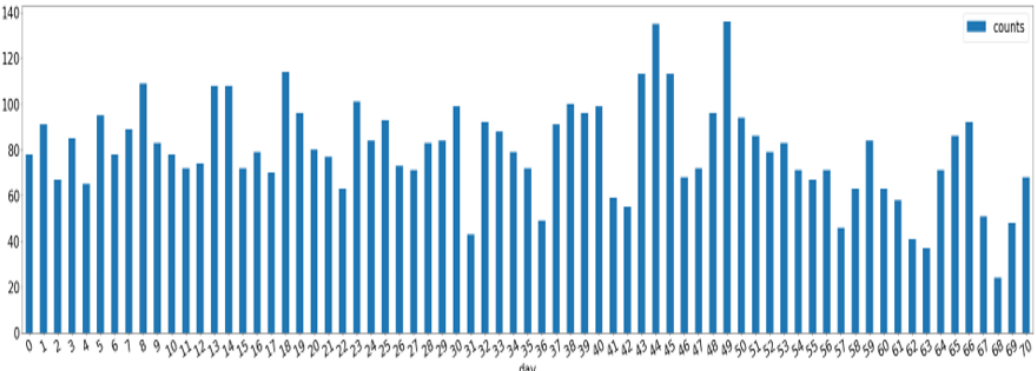
Figure 16. Number of satellite images on days of cabbage growth.